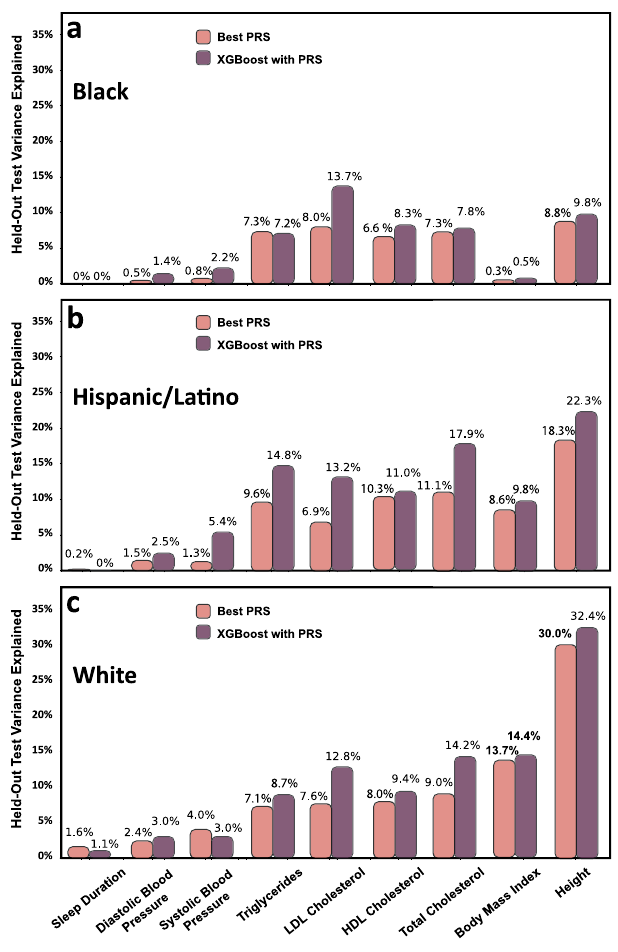
Fig. 4 Model performance differ by group, with XGBoost consistently outperforming PRS. Performance of the PRS (pink) and XGBoost + PRS (purple) models trained on the combined dataset when applied to the prediction of the 5 phenotypes in separate race/ethnicities. Panels a , b , and c refer to White, Black and Hispanic/Latino groups,